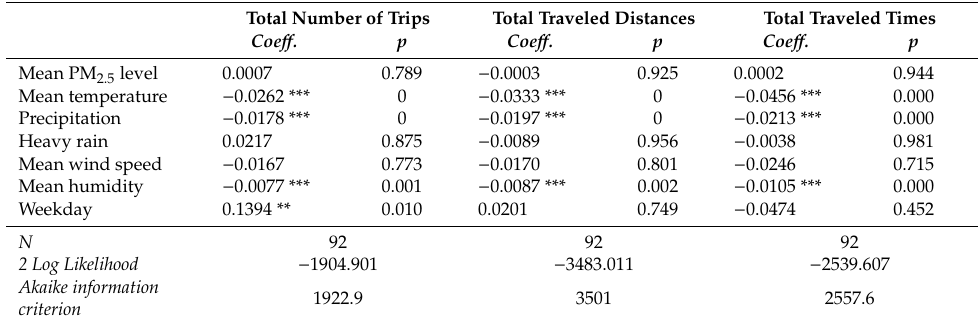
Table 8. Estimation results for bike sharing use using PM 2.5 level data in